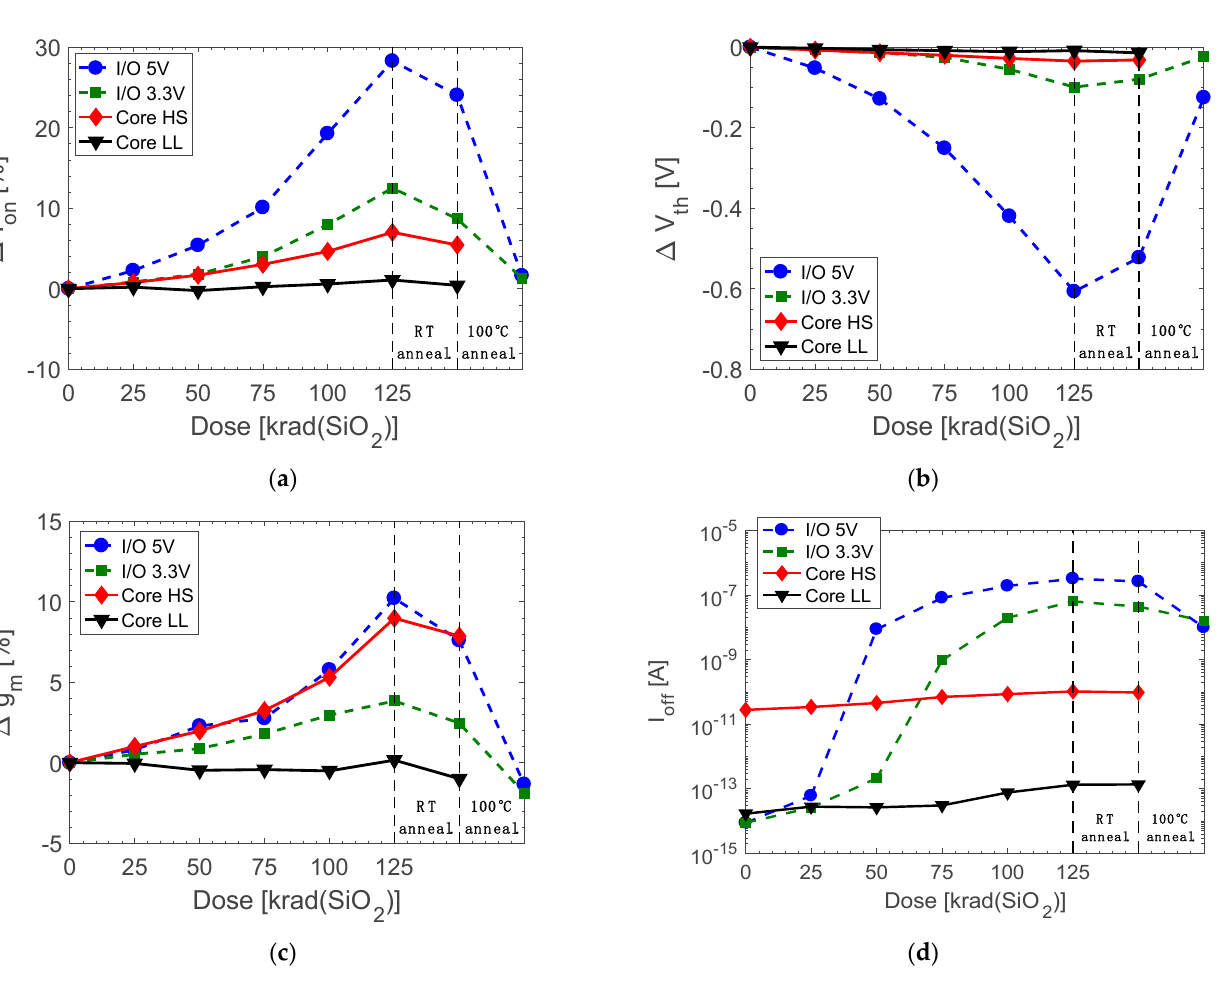
Figure 4. Variations in ( a ) maximum current Δ I on , ( b ) threshold voltage Δ V th , ( c ) transconductance Δ g m and ( d ) leakage current I off as a function of dose for the four transistor types: I/O 5V, I/O 3.3V, core HS and core LL. The channel geometries are the narrowest and shortest: W/L = 0.8 μ m/10 μ m for I/O devices, and W/L = 0.35 μ m/10 μ m for core devices. The plots show the main DC parametric shifts at room temperature in nMOSFETs in the linear region ( V ds = 0.1 V). All transistors are